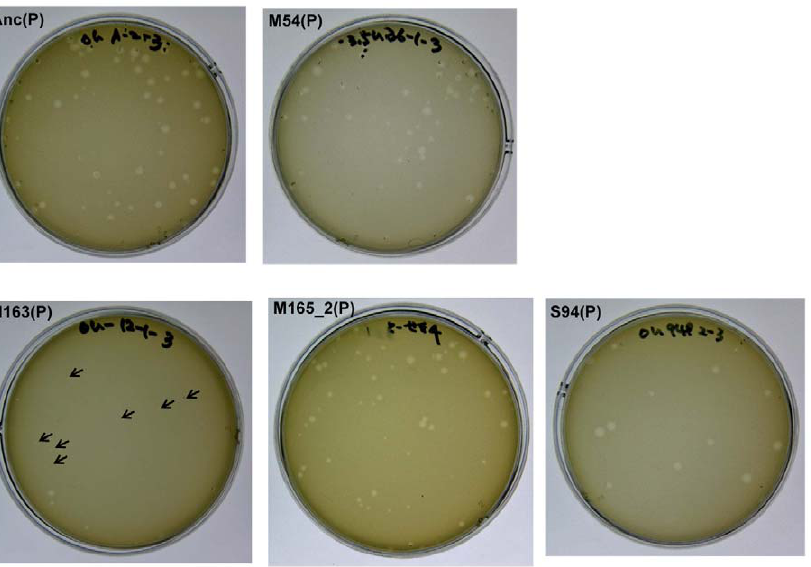
Figure 3. Differences in plaque size between Anc(P) and evolved Q b . Plaque size was analyzed using A/ l as an indicator strain on LB agar medium. Most of the plaques of Anc(P) were large but some small plaques were also found. Both large and small plaques reproduced heterogeneity in plaque size (data not shown). In the copropagation regime, the plaque size decreased with number of generations, and plaques of M163(P) became quite small (indicated with arrows), while the plaques of M165_2(P) were still heterogeneous. In the Q b propagation regime, the plaque size of S94_3(P) became uniformly large.